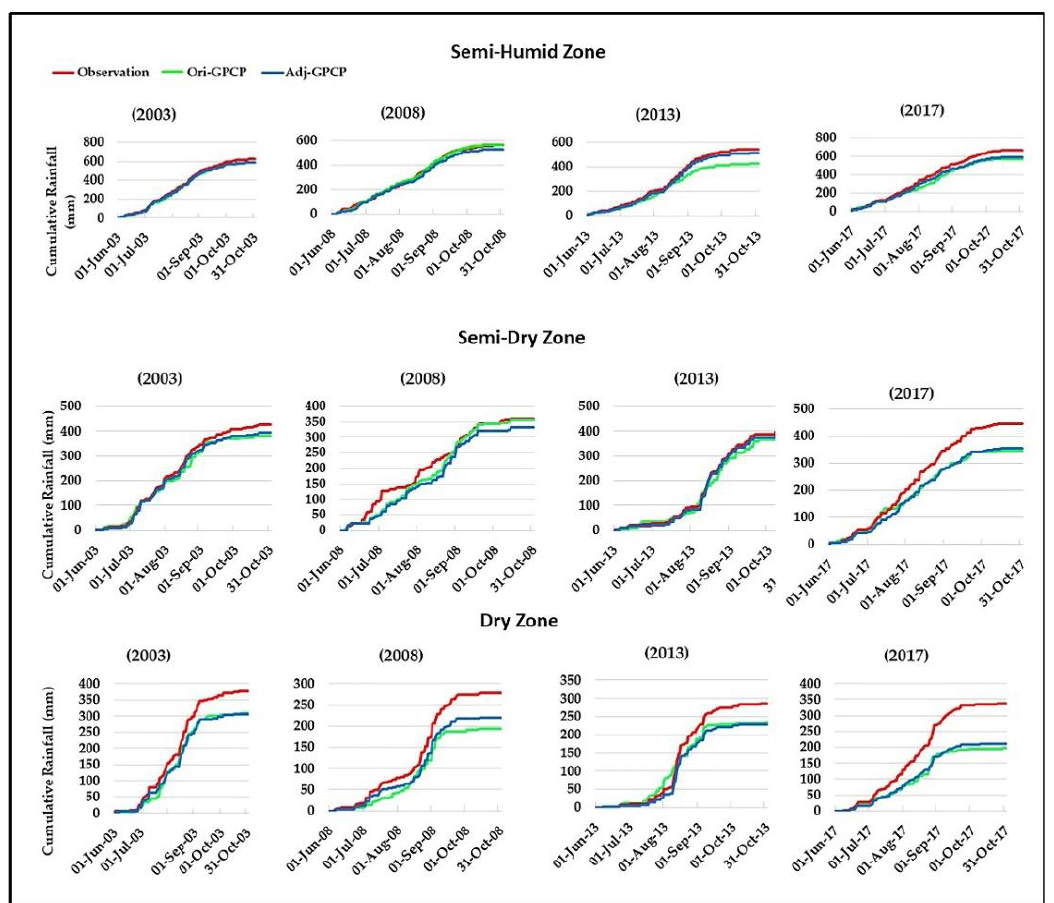
Figure 12. The cumulative rainfall for gauge observations, Ori- GPCP, and Adj- GPCP.